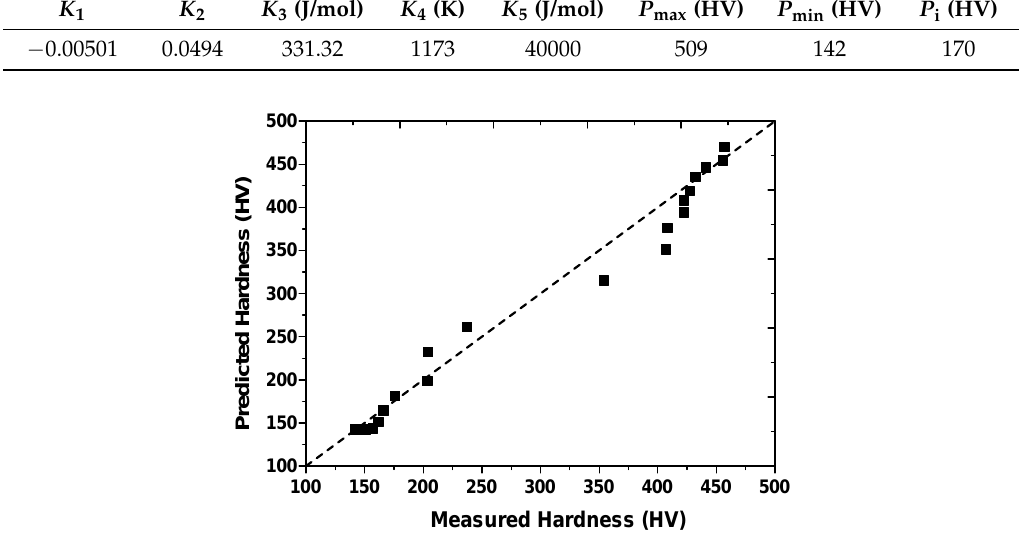
Figure 4. Comparison of hardness between measurement and prediction on the dilatometer test.